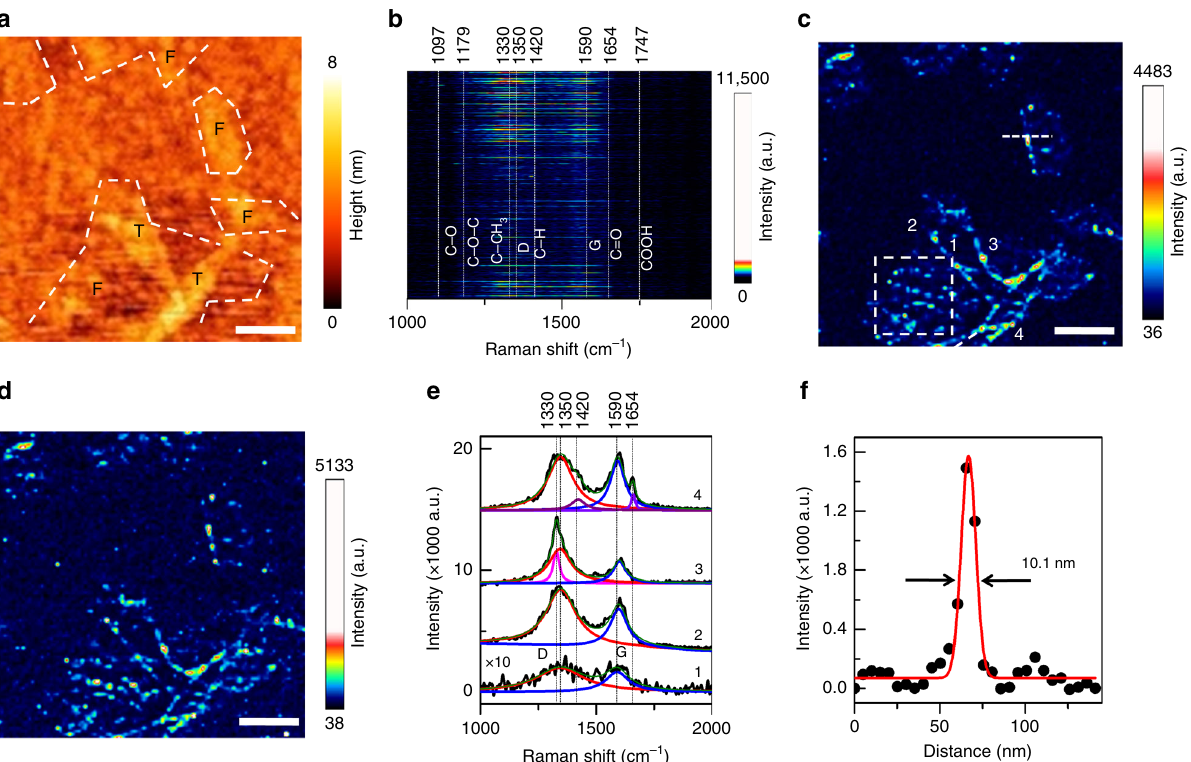
Fig. 2 High-resolution TERS mapping of a GO – COOH fl ake. a Topography map of a multilayer GO – COOH sample obtained whilst TERS mapping. “ T ” and “ F ” refer to thick-layer and few-layer GO – COOH fl akes, respectively. b Image of the stacked TERS spectra measured from 100 × 100 pixels across the GO – COOH sample area shown in ( a ). TERS spectra are stacked in the order of their acquisition with the 1st and the 10,000th TERS spectrum presented at the bottom and top of the image, respectively. TERS maps of c D band (1350 cm − 1 ) intensity and d G band (1590 cm − 1 ) intensity measured from the GO – COOH sample area shown in ( a ). Nominal pixel dimension: 10 nm. Integration time: 0.4 s. e TERS spectra measured at the locations marked 1 – 4 in ( c ) along with the fi tted Lorentzian curves. The intensity of the averaged TERS spectrum from location 1 has been multiplied by 10 for easier visualisation. f TERS intensity pro fi le along the white dashed line marked in ( c ) fi tted with a Gaussian curve. All scale bars: 200